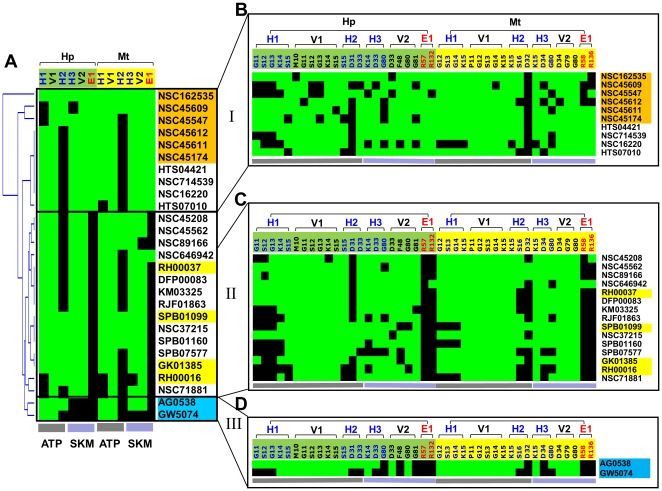
Interaction profiles between selected anchor residues and 27 tested compounds.(A) Anchor profile of tested compounds on shikimate kinases. (B) Group I: NCI compounds (orange). (C) Group II: Maybridge compounds (yellow). (D) Group III: kinase inhibitors (cyan). The NCI compounds consistently occupy anchors E1 and V2 at both ATP and shikimate sites. The NCI compounds except NSC45174 are competitive inhibitors with both ATP and shikimate. For the Maybridge compounds, none form electrostatic interactions with R57 and R132 on the consensus anchor E1. The two kinase compounds are located at the ATP site, which fact is consistent with the kinetic results that reveal that these compounds exhibited competitive inhibition with ATP and noncompetitive inhibition with shikimate.